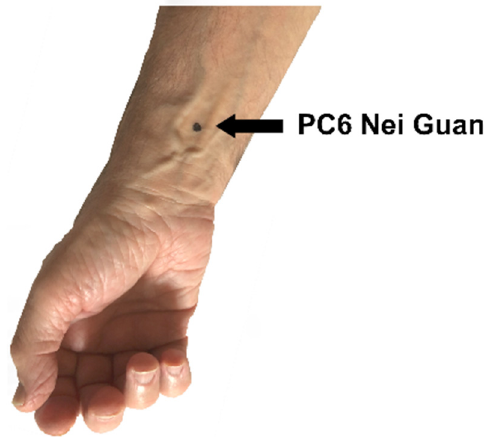
Figure 1. The location of PC6 Nei Guan. TCM clinical indications for PC6 Nei Guan are related to the heart (chest pain, pal- pitations, and oppression), to gastric disturbances (gastric pain, nausea, and vomiting) and to neurological conditions such as anxiety, irritability, depression, and insomnia.